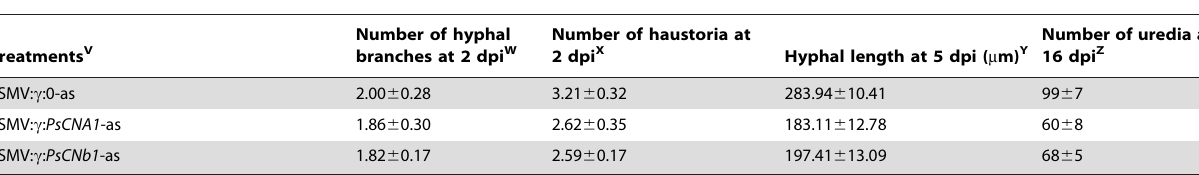
Table 2. Histological observation during HIGS (mean 6 SE).